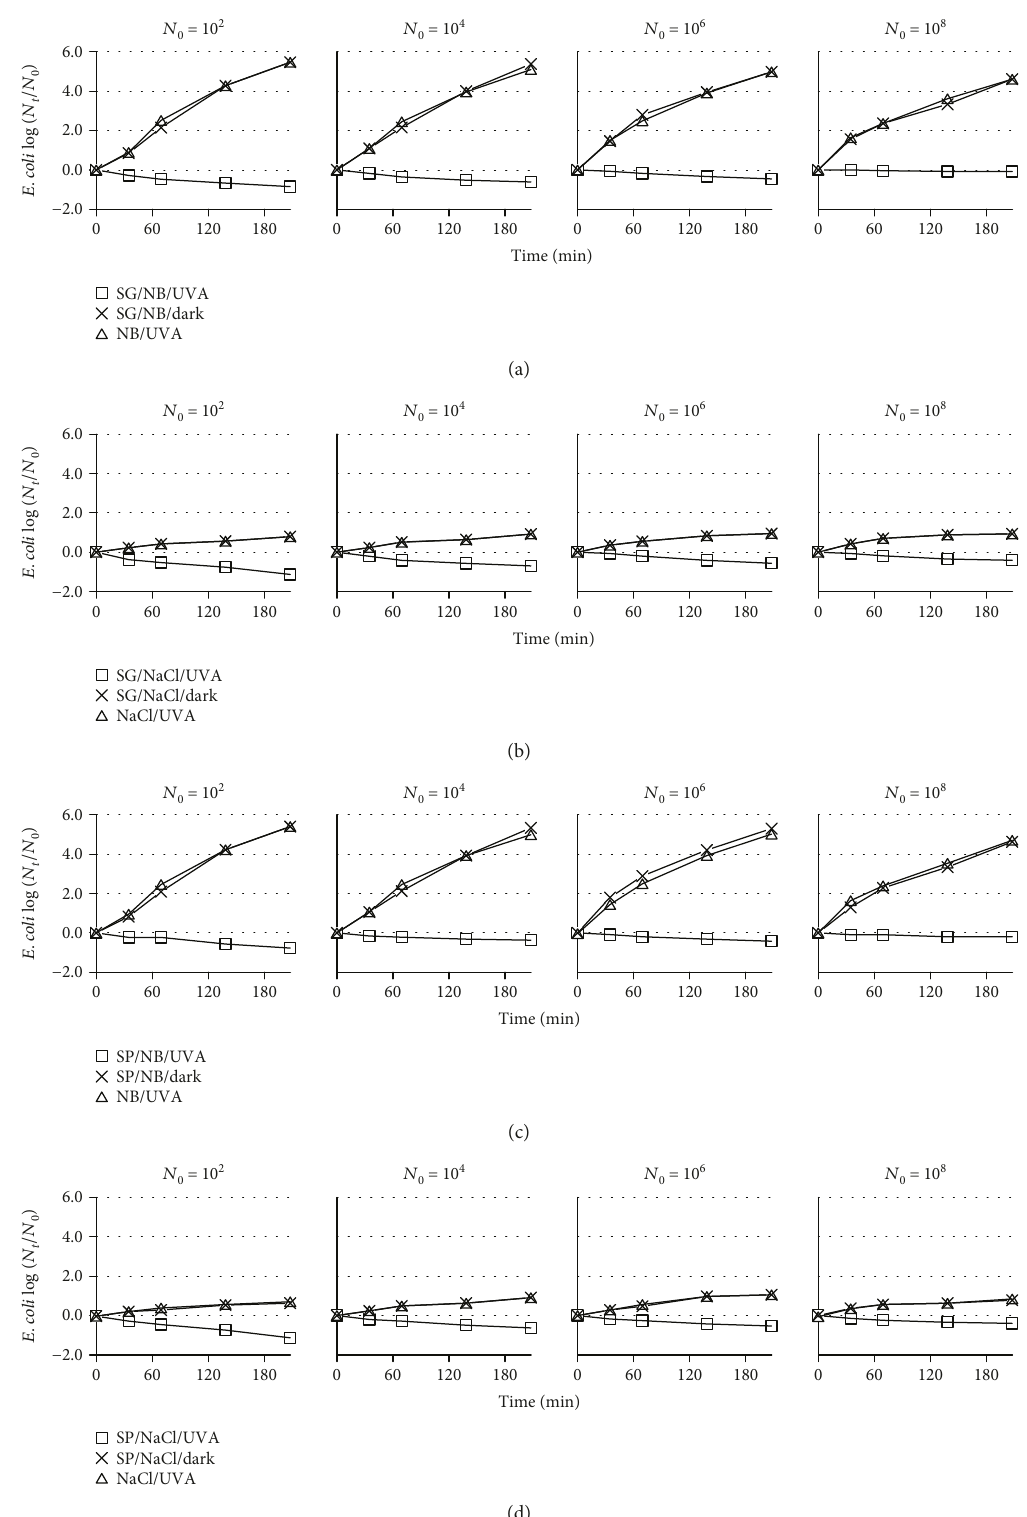
Figure 8: The photocatalytic bacterial inactivation, given the initial E. coli concentrations in NB and 0.85% NaCl of 10 2 , 10 4 , 10 6 , and 10 8 CFU · mL − 1 : (a) NB treated with SG-TiO thin fi lm and UVA relative to the control (SG/NB/dark and NB/UVA), (b) NaCl treated with 2 SG-TiO thin fi lm and UVA relative to the control (SG/NaCl/dark and NaCl/UVA), (c) NB treated with SP-TiO 2 UVA relative to the control (SP/NB/dark and NB/UVA), and (d) NaCl treated with SP-TiO control (SP/NaCl/dark and